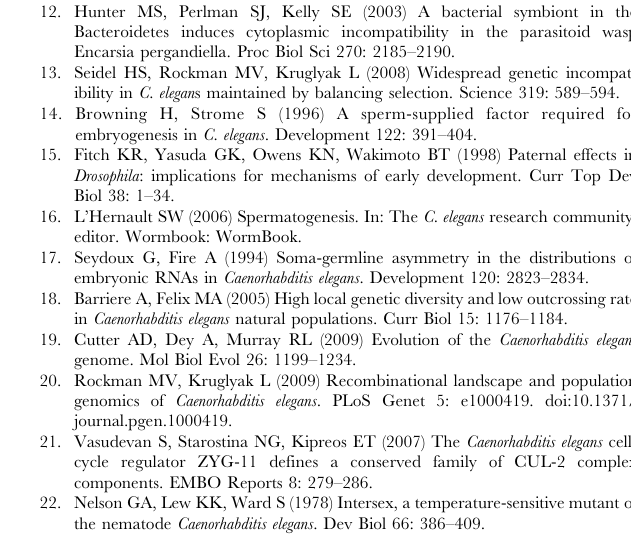
Figure S8 Ectopic expression of peel-1 and zeel-1 . (A) The full dataset used to generate the plot in Figure 8C is shown. As described in Figure 8C, the following classes of embryos, aged 3 to 7.5 h post-four-cell stage, were heat-shocked for 20 min at 34 u C: (i) wild-type; (ii) zeel-1( D )/zeel-1( D ) embryos carrying a Phsp-